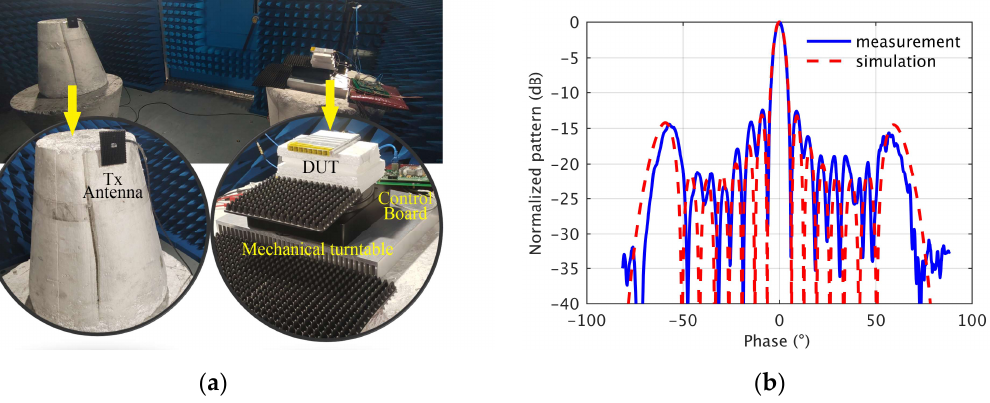
Figure 25. ( a ) The pa(cid:308)ern measurement platform. ( b ) The normalized pa(cid:308)ern simulation and measurement results.